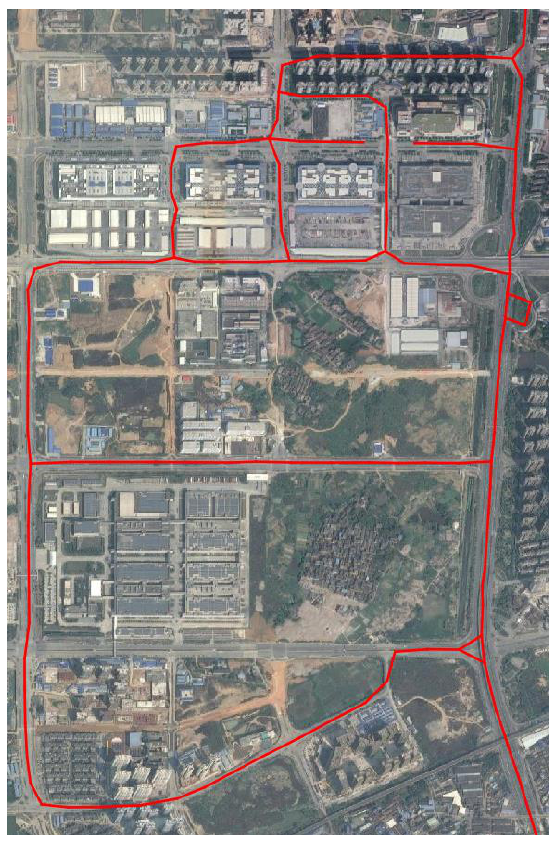
Figure 17. Comparison between road network and high-definition satellite map ( ε = 9 ).